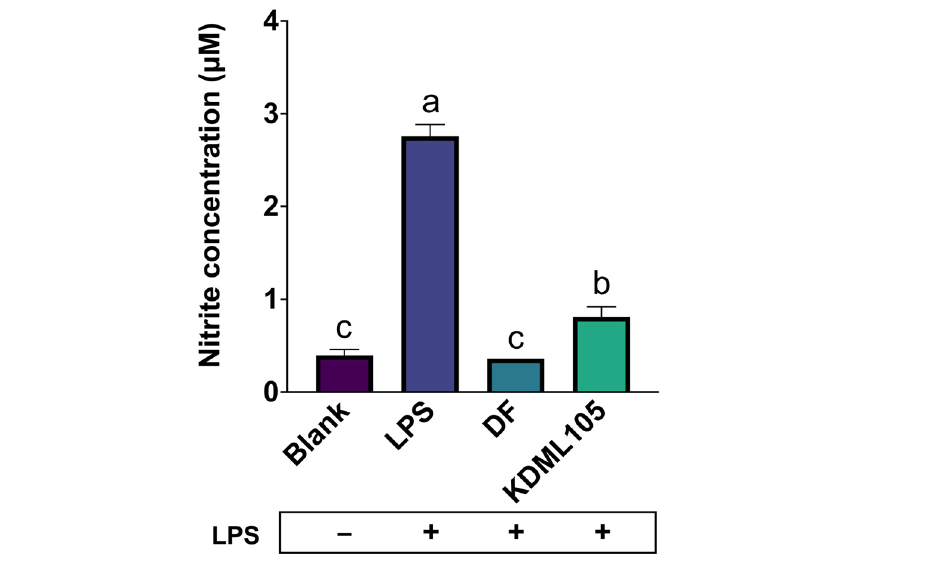
Figure 3. The nitrite level ( μ M) in RAW 264.7 murine macrophages after lipopolysaccharide (LPS) stimulation for 24 h. Diclofenac sodium (DF) or Oryza sativa L. cv. Khao Dawk Mali 105 (KDML105) bran extract was pretreated at 0.1 mg/mL to inhibit nitrite production, and these pretreatments were compared to the solvent-treated group without LPS (blank) and the LPS-stimulated group (+LPS). Different alphabets represent significant differences ( p < 0.05) between groups.